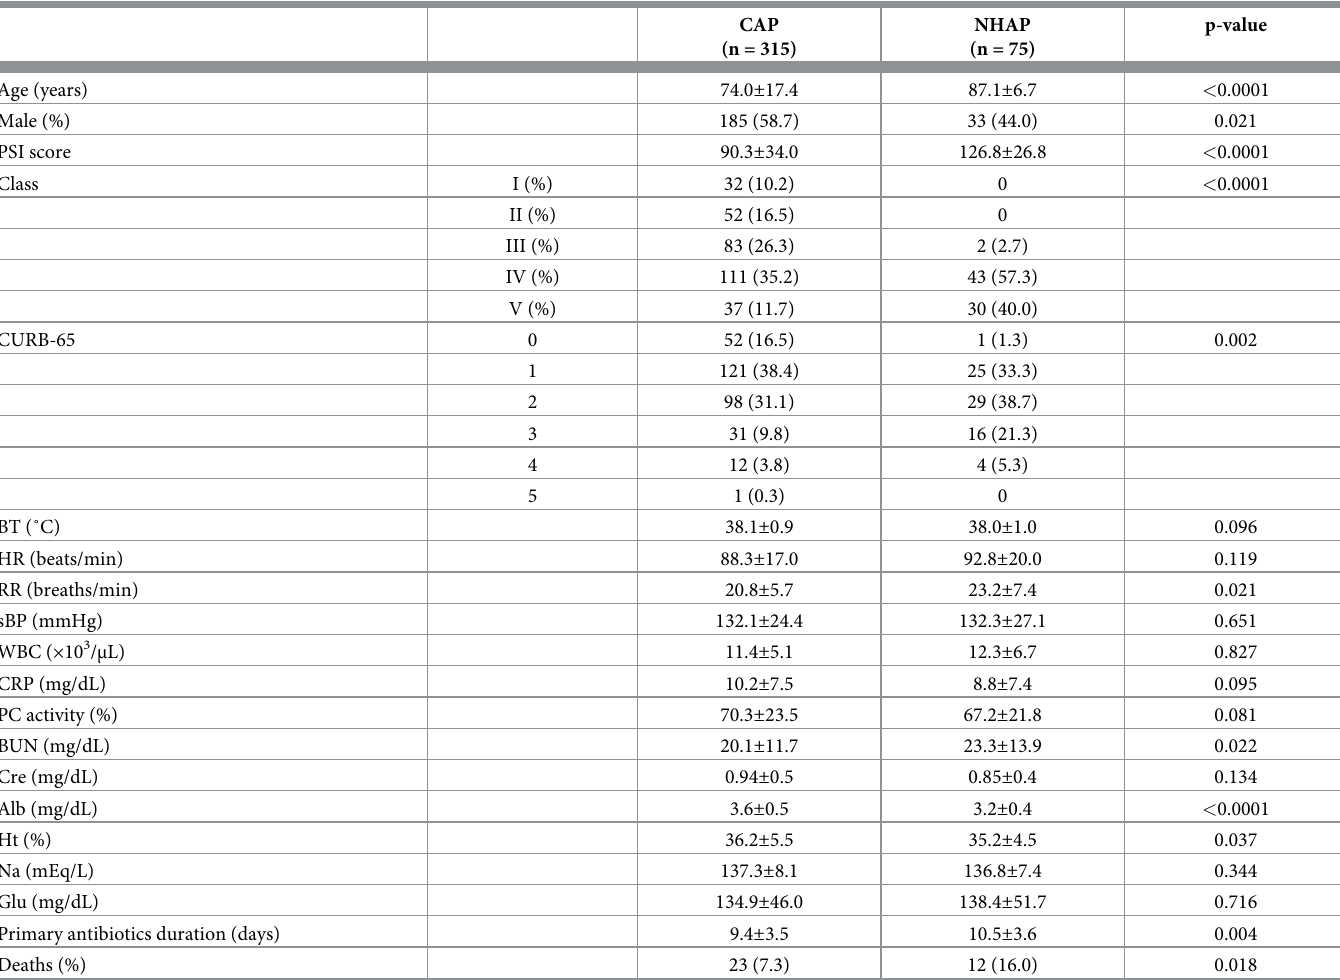
Table 1. Baseline clinical characteristics of enrolled